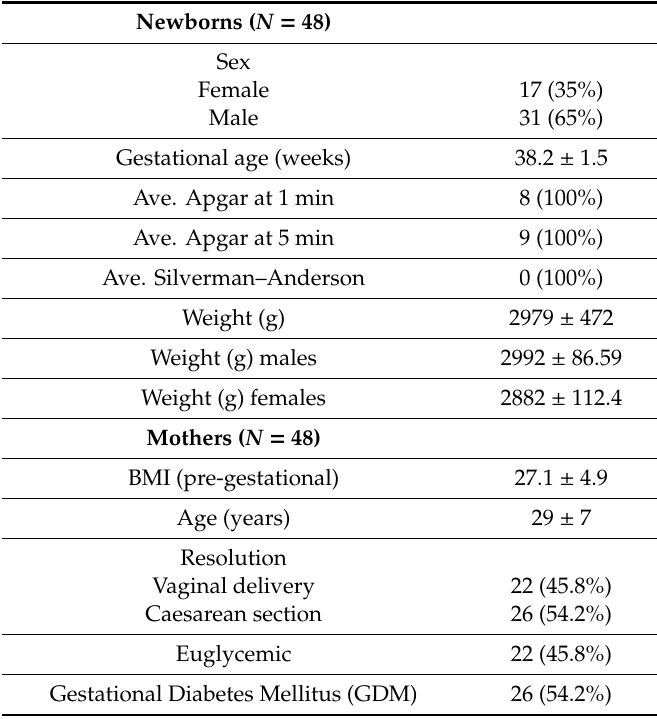
Table 1. Clinical data from the newborns and their